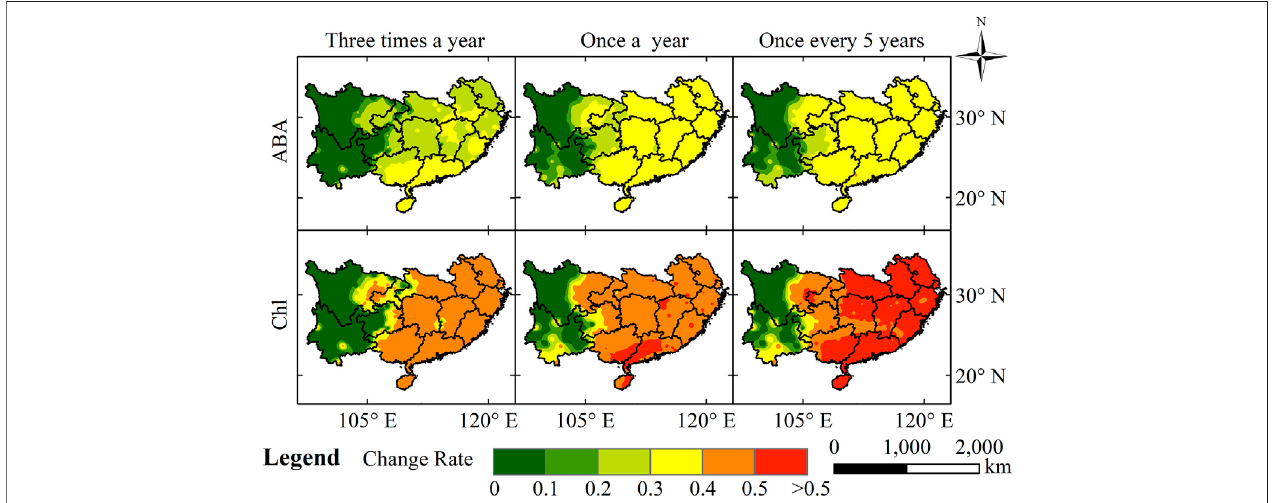
FIGURE 7 | The spatial distribution of the potential loss rates of ABA and Chl caused by HTHH events in southern China with return periods of three times a year, once a year, and once every 5 years.